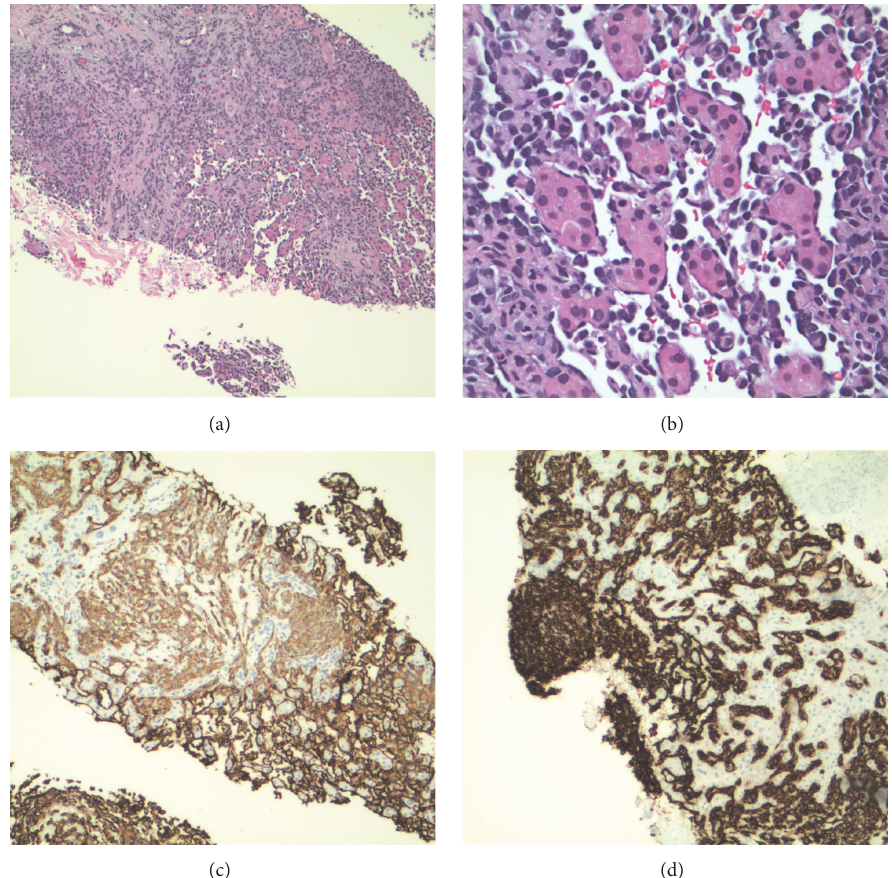
Figure 2: (a) 100x angiosarcoma H&E demonstrating tumor with high cellularity and prominent vascular network. (b) 400x angiosarcoma H&E demonstrating vasculature lined by plump, pleomorphic, endothelial cells. (c) 100x demonstrating CD31 positivity. (d) 100x demonstrating CD34